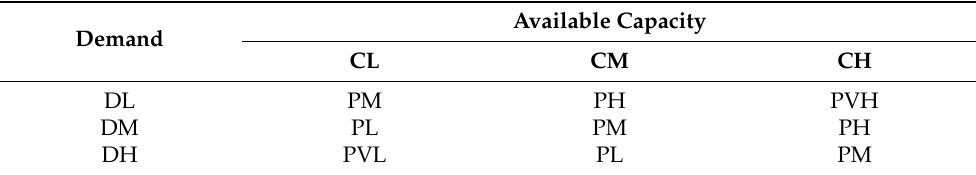
Figure 4. Fuzzy sets for the preference strength to visit the customer i . Table 2. Reasoning rules determining the visit preference strength.